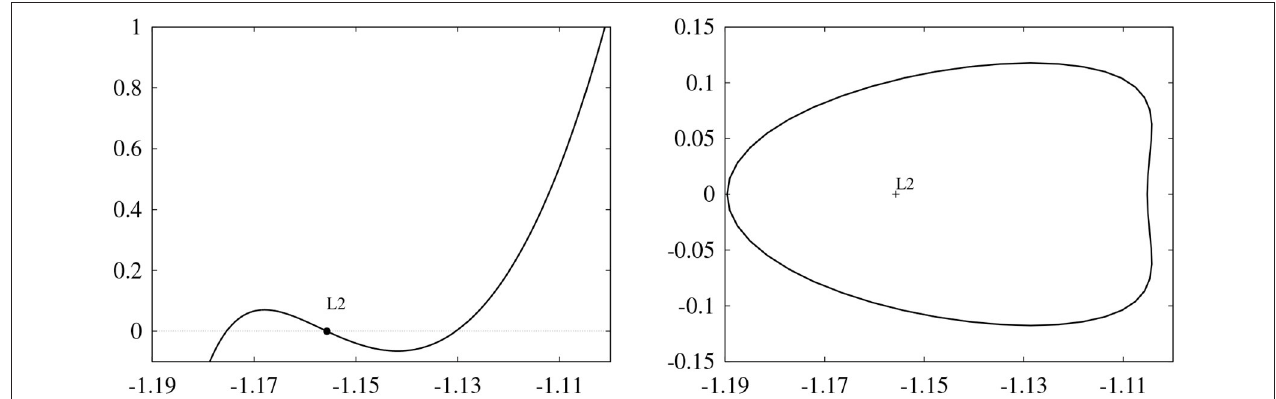
FIGURE 6 | Left: Continuation of L 2 as a periodic orbit with respect to the mass of the Sun. Horizontal axis: x . Vertical axis: ε . See text for more details. Right: Periodic orbit near L 2 in the BCP. Horizontal axis: x . Vertical axis: y